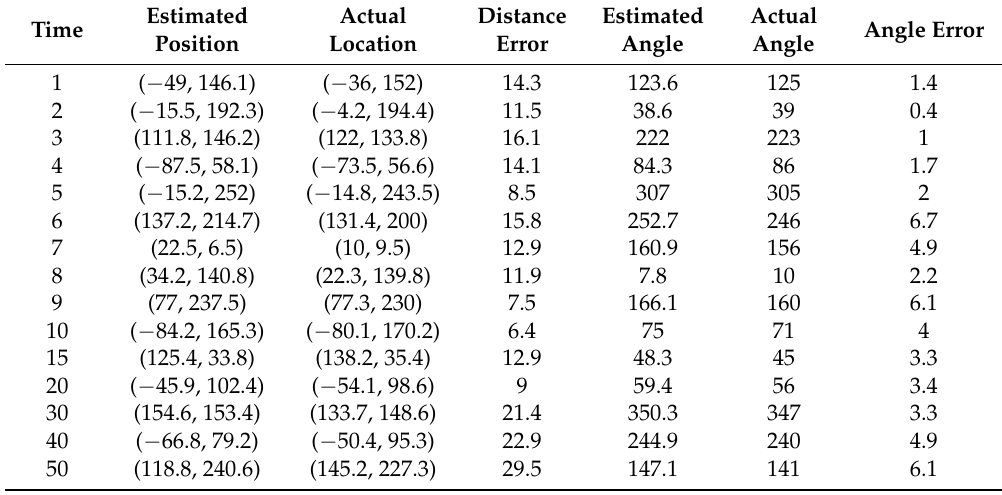
Table 10. Comparison of adding six-axis sensors (speed 50